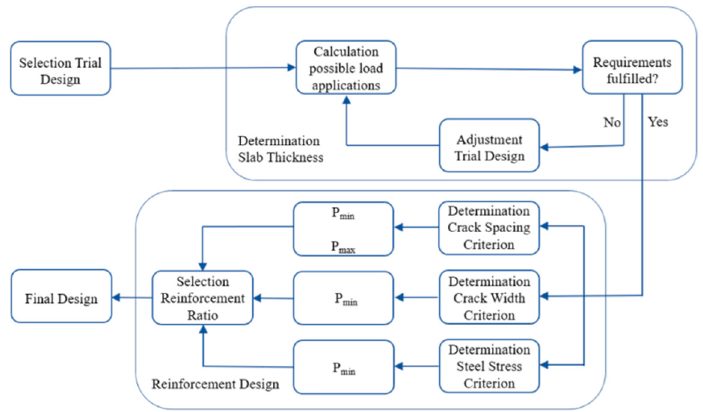
Figure 7. The procedure for dimensioning according to the AASHTO 86/93 method.